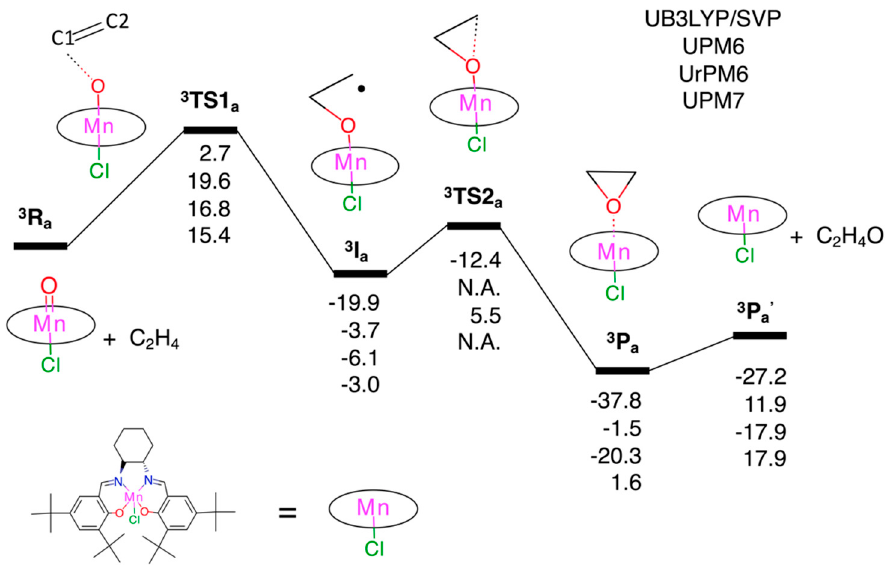
Figure 2. Potential energy profile with zero-point energy corrections (in kcal/mol) relative to the isolated 3 [Cl–Mn V =O(salen)] complex and ethylene ( 3 R a ) obtained at the UB3LYP/SVP, UPM6, UrPM6, and UPM7 levels of theory. The superscript 3 on the left side denotes triplet spin state, and N.A. represents not available (Geometry optimizations failed).